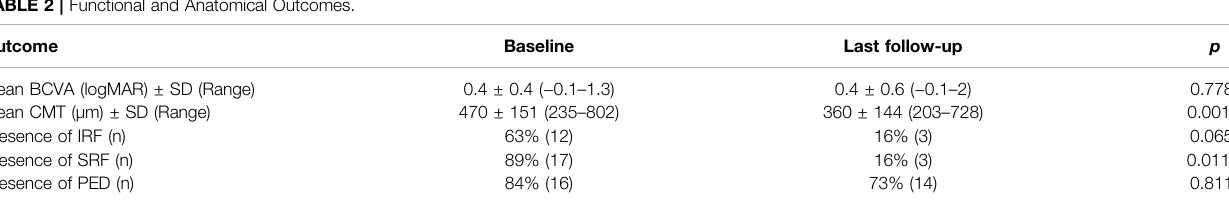
TABLE 2 | Functional and Anatomical Outcomes.